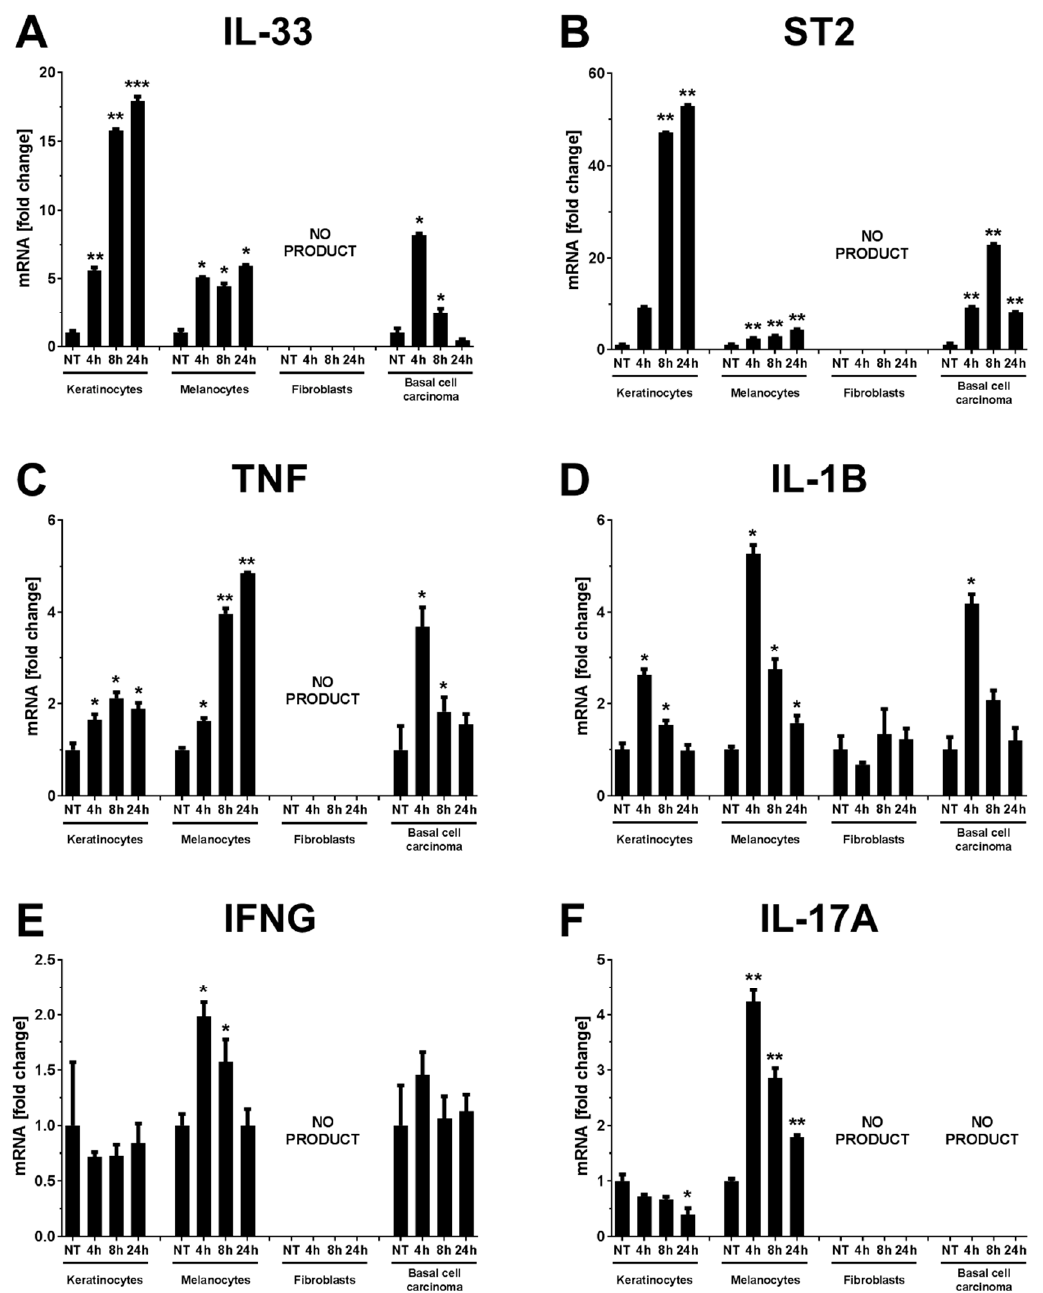
Figure 1. Vitamin D modulates the expression of IL-33 , ST2 , TNF , IL-1B , IFNG and IL-17A in skin cell lines. Keratinocytes (HPEKp), melanocytes (HEMas), fibroblasts (HDF) and basal cell carcinoma cells (A431) were stimulated with 1,25(OH)2D3 (100 nM) for 4, 8 and 24 h. The relative IL-33 ( A ), ST2 ( B ), TNF ( C ), IL-1B ( D ), IFNG , ( E ) and IL-17A ( F ) mRNA levels were analyzed by real-time PCR. * p < 0.05, ** p < 0.01, *** p <